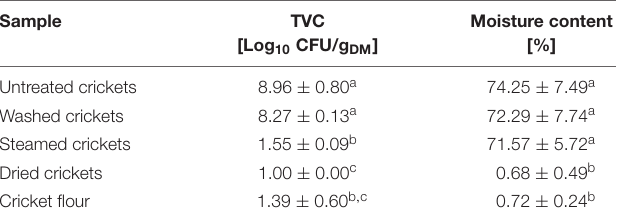
TABLE 3 | TVC and moisture content of crickets along the processing chain of cricket flour (thermal treatment: steaming; oven-drying: 110 ◦ C, 8